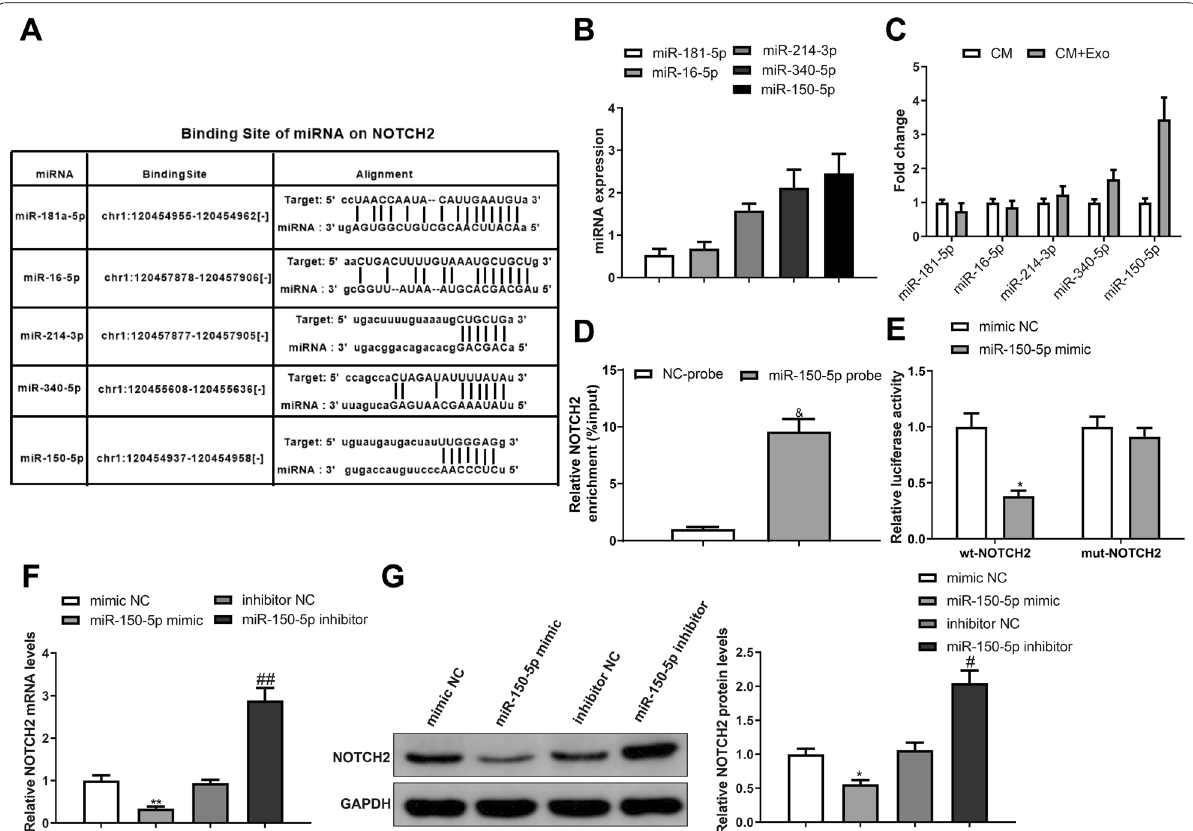
Fig. 6 Exosomal miR-150-5p targets NOTCH2 in microglial cells. A StarBase predicted the miRNA-binding sites on NOTCH2; B RT-qPCR detected the expression of NOTCH2-binding miRNAs in BMSC-exosomes; C RT-qPCR detected the expression of the NOTCH2-binding miRNAs in microglial cells that were incubated with BMSC-exosomes or not; RNA pull down assay D and dual-luciferase reporter assay E verified the targeting relationship between miR-150-5p and NOTCH2; RT-qPCR F and western blotting G were used to detect the expression of NOTCH2 in microglial cells overexpressed or underexpressed miR-150-5p. Data were shown as mean standard deviation. Cellular experiments were repeated thrice. * P < 0.05, ± vs. the mimic NC or CM group; # P < 0.05, vs. the inhibitor NC group; & P < 0.05, vs the NC-probe group. BMSC bone marrow mesenchymal stem